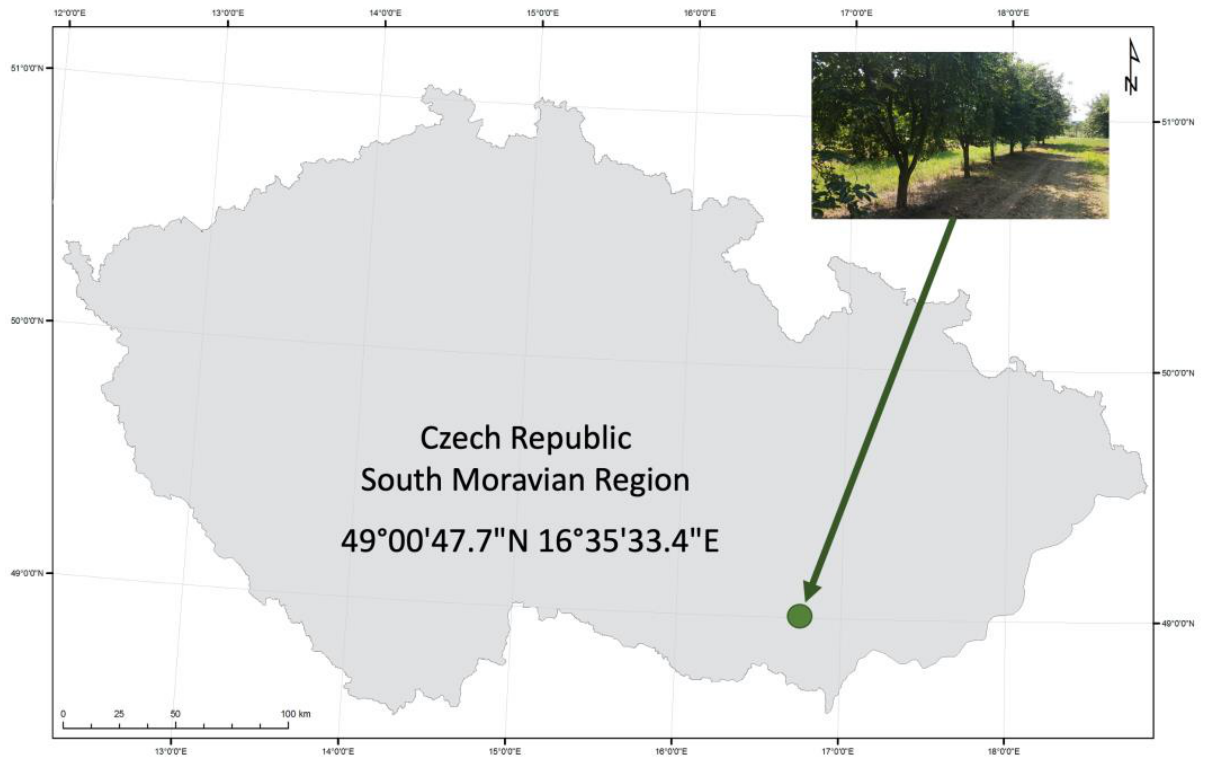
Figure 1. Location of the study area where vegetation of the sour cherry orchard was evaluated. The sour cherry orchard is owned and managed by the School Farm Žabˇcice (Mendel University in Brno). The area of interest lies in the Graben Dyjsko-Svrateck ý basin, which rests mainly by Neogene sediments. The geological formation is composed of Quaternary gravels and partly of alluvial sediments. The soils here are neutral to moderately acidic with a lack of humus. The land contains black soil with a total skeleton content of up to 25%. The soil profile is deep to medium deep and consists mainly of sandy soils. The land is flat with an average altitude of 186.69 m above sea level. The long-term (years 1991 to 2020) average annual temperature is 9.2 ◦ C and the long-term average annual rainfall is 481 mm. The data come from the Meteorological Station of the Department of Agrosystems and Bioclimatology—Žabˇcice, Mendel University in Brno. Drought in the area is caused by the uneven distribution of rainfall, drying winds, and rain shadow